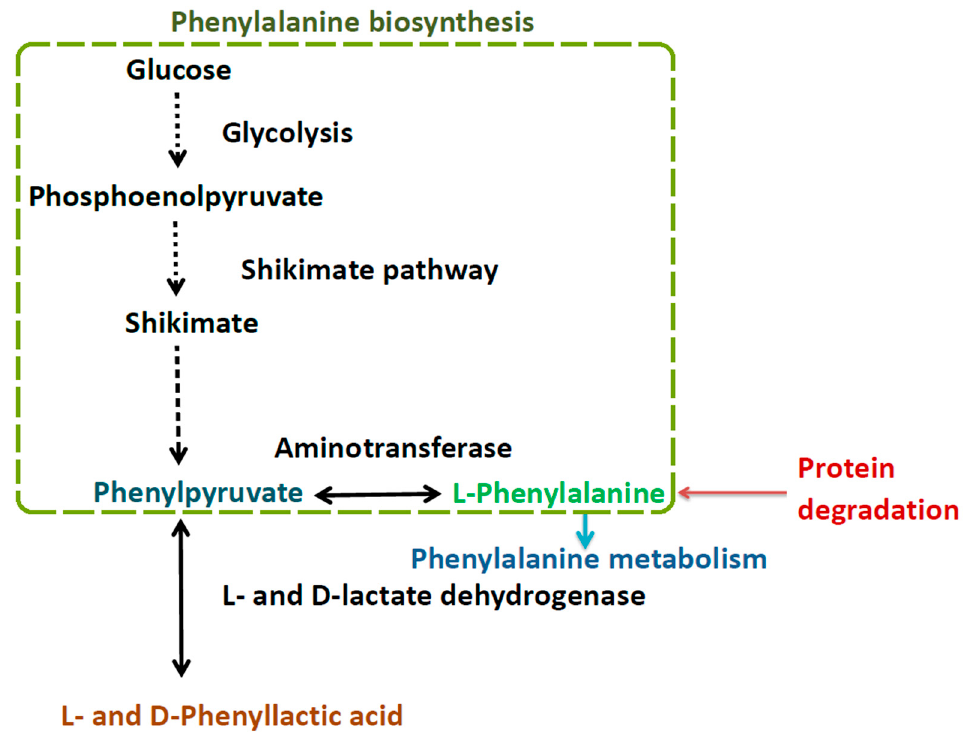
Figure 1. Biosynthesis of 3-Phenyllactic acid.